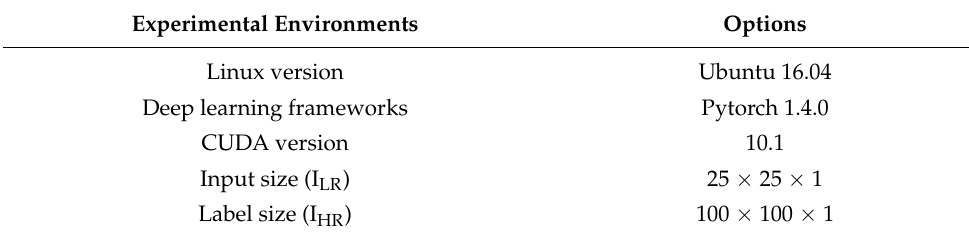
Figure 6. Test datasets (Set5 [38], Set14 [39], BSD100 [40], and Urban100 [41]). Table 2. Experimental environments.